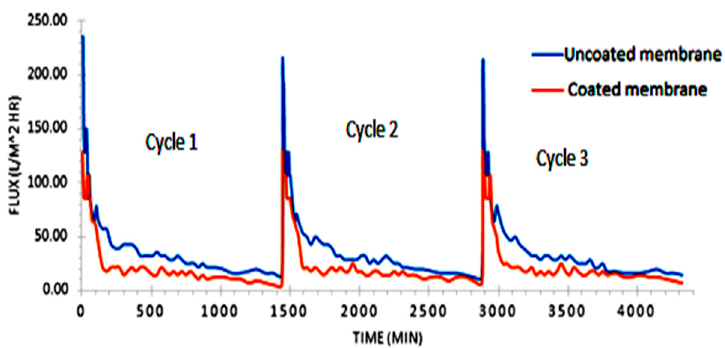
Figure 2. Variation of permeate flux with time of operation for both sets of membranes.